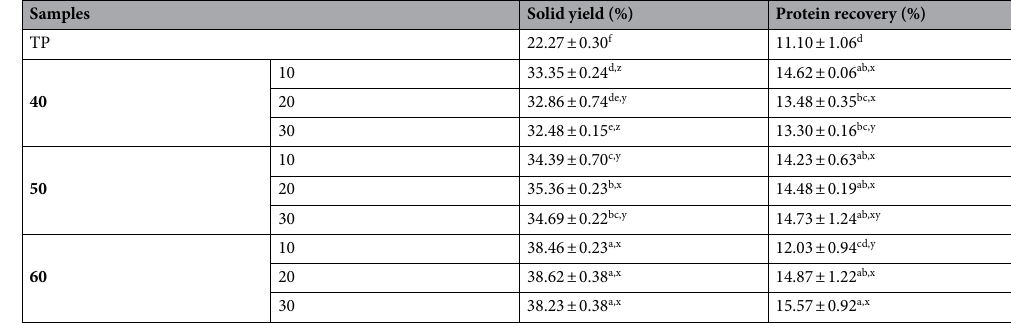
Table 1. Solid yield and protein recovery of protein extracted from Bombay locust by ultrasound-assisted process under different conditions. Data are expressed as mean ± standard deviation (n = 3). TP, Typical extraction process (without ultrasound-assisted process). 40, 50, 60; Amplitudes of ultrasound-assisted process (%). 10, 20, 30; Ultrasonication times (min). a,b,c … indicated significant differences of data in the same column ( P < 0.05). x,y,z indicated significant differences of data comparing in the same ultrasonication time ( P <